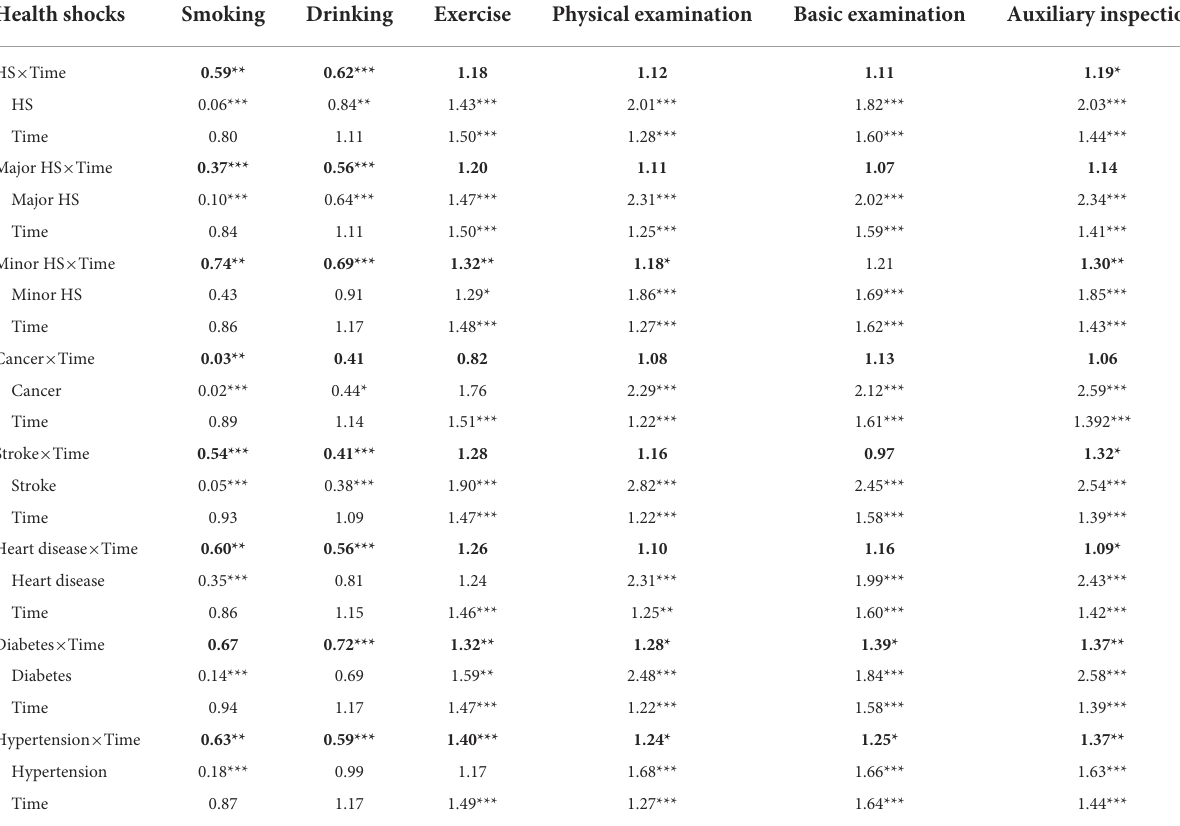
TABLE 3 Odds ratios from multilevel PSM-DID regression models predicting the effect of health shocks on preventive